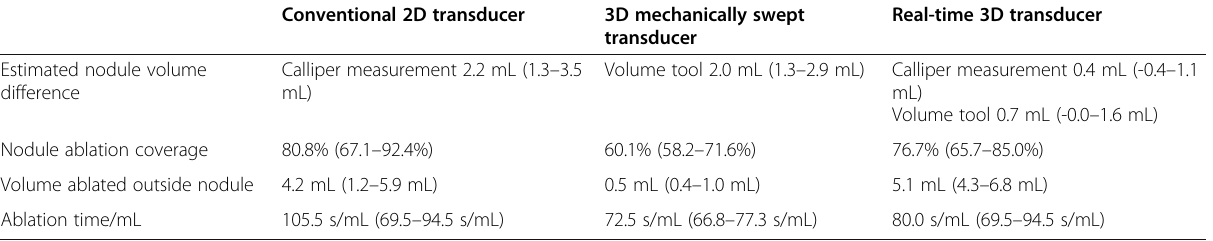
Table 2 Overview of the four main results shown with medians and interquartile ranges